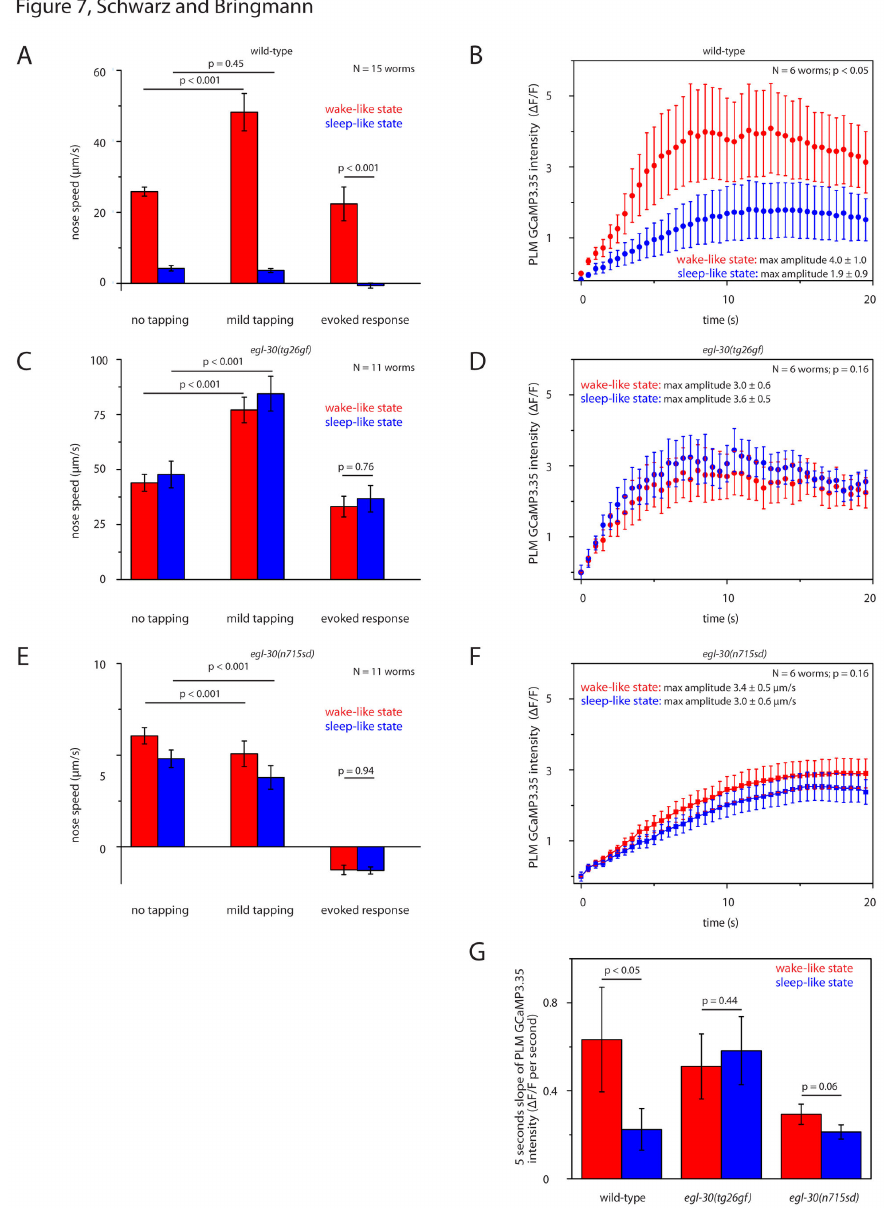
Figure 7. Reduced decrease of responsiveness to mechanical stimulation in egl-30 mutants during lethargus. A Evoked dish tapping-induced behavioral response was reduced during wild type lethargus. “evoked response” was defined as nose speed during “mild tapping” minus nose speed before tapping (“no tapping”). B Dish tapping-induced calcium transients in mechanosensory neurons were reduced during wild type lethargus. C Evoked behavioral response to dish tapping in egl-30 (tg26gf) mutants was not reduced during sleep-like behavior. Compared with wild type, the evoked response of egl-30 ( tg26gf ) was not reduced during wake-like behavior, but was significantly reduced during sleep-like behavior (p < 0.001, t-test). D Evoked calcium transients in mechanosensory neurons were not reduced during lethargus in egl-30 (tg26gf). E Evoked behavioral response to dish tapping in egl-30 (n715sd) mutants was not reduced during sleep-like behavior. Compared with wild type, the evoked response of egl-30 ( n715sd ) was not reduced during sleep-like behavior, but was significantly reduced during wake-like behavior (p < 0.001, t- test). F Evoked calcium transients in mechanosensory neurons were less reduced during lethargus in egl-30 (n715sd). G Slope of the tapping-induced calcium transient in mechanosensory neurons during the first five seconds. While the initial slope was significantly decreased during sleep-like behavior in wild type (paired sample Wilcoxon test), the difference between wild type and egl-30 mutants was not statistically significant. doi: 10.1371/journal.pone.0075853.g007 PLOS ONE |